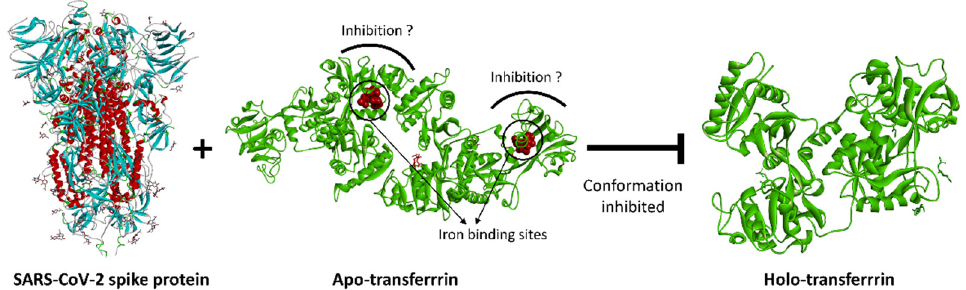
Figure 8. A schematic model of how SARS-CoV-2 (PDB code: 7jwy) may block the uptake of Fe 3+ , resulting in apo-transferrin-like conformation (PDB code: 2hau), maybe leading to the inhibition of holo-transferrin conformation (PDB code: 3v83).